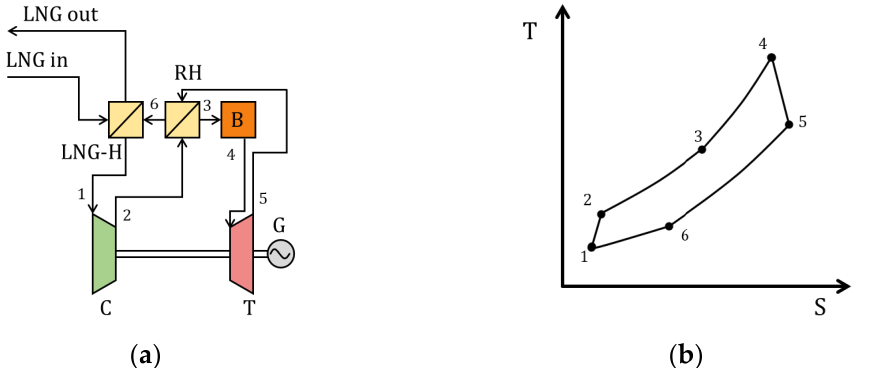
Figure 12. Supercritical CO 2 Brayton cycle using liquefied natural gas for precooling: ( a ) schematic diagram; ( b ) T – S diagram [21]. B — boiler; T — turbine; C — compressor; LNG-H — LNG heater; RH —